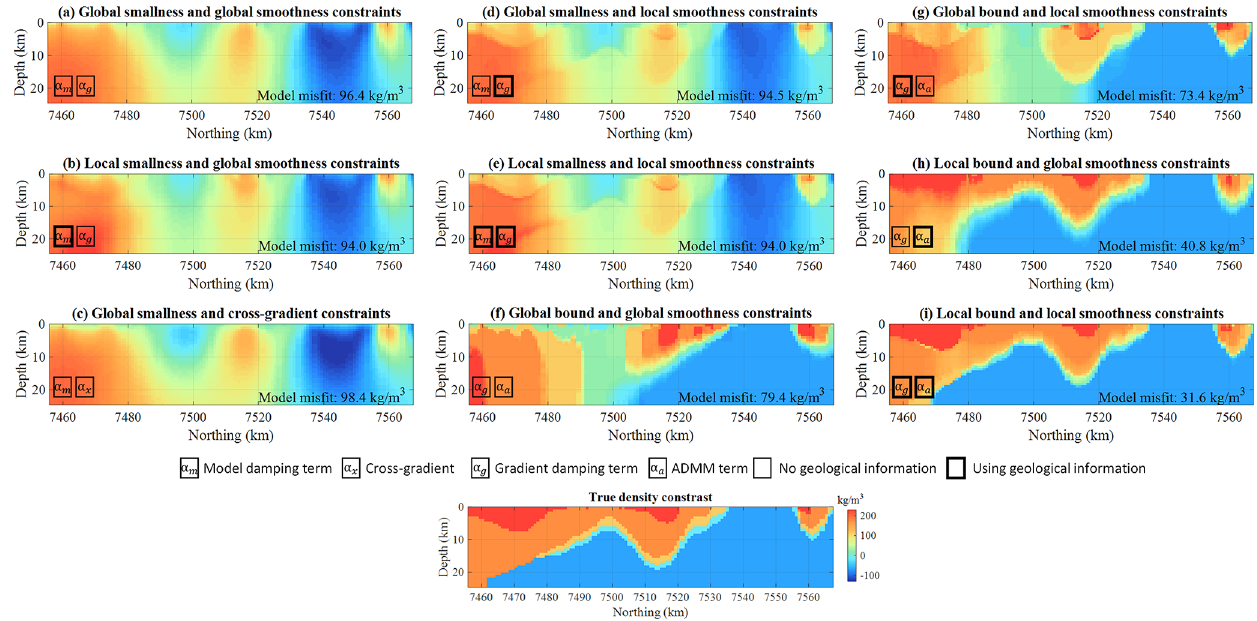
Figure 17. General comparison of all inversion results obtained from gravity inversion. The legend identifies the different types of inversion shown. We repeat the true model at the bottom. The model misfit indicated on each panel is calculated as the root mean square of the difference between the inverted and true